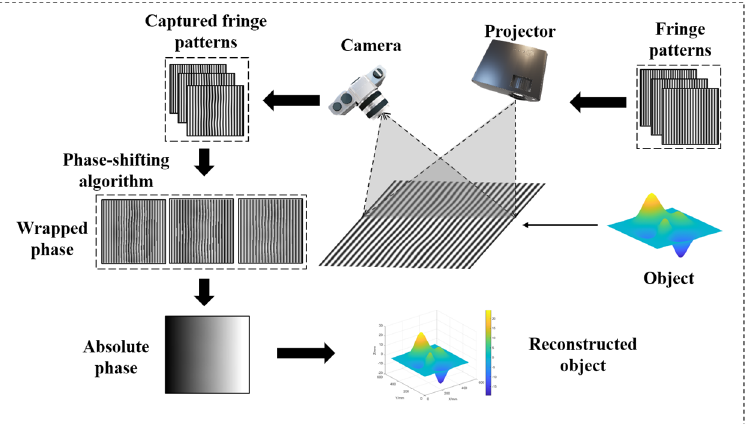
Figure 1. Schematic diagram of an FPP setup.